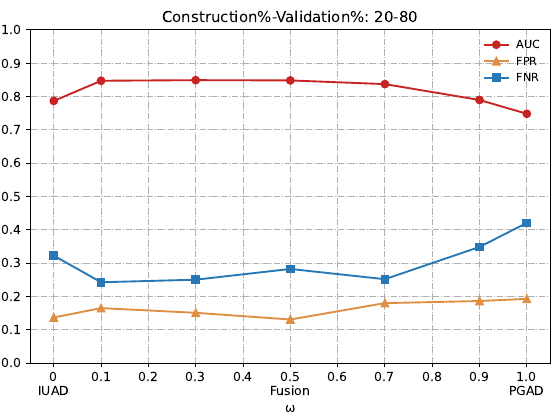
Figure 11. Detection results of the IUAD, the PGAD and the Fusion model in terms of AUC, FPR,